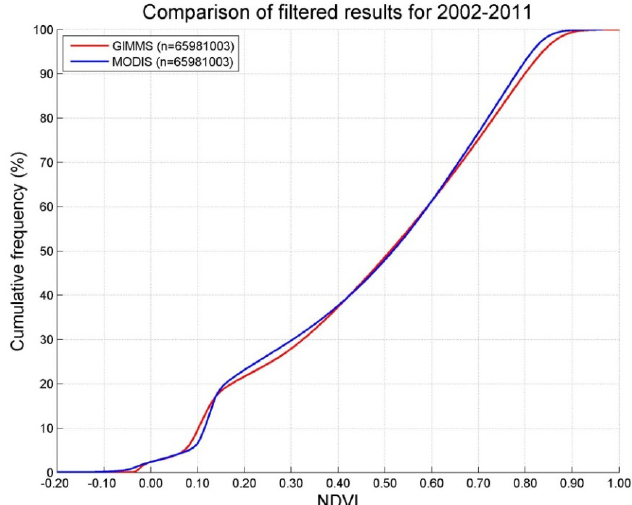
Figure 3. Data distribution of GIMMS and MODIS time series (weekly data) extracted from the full image extent and pooled across all years